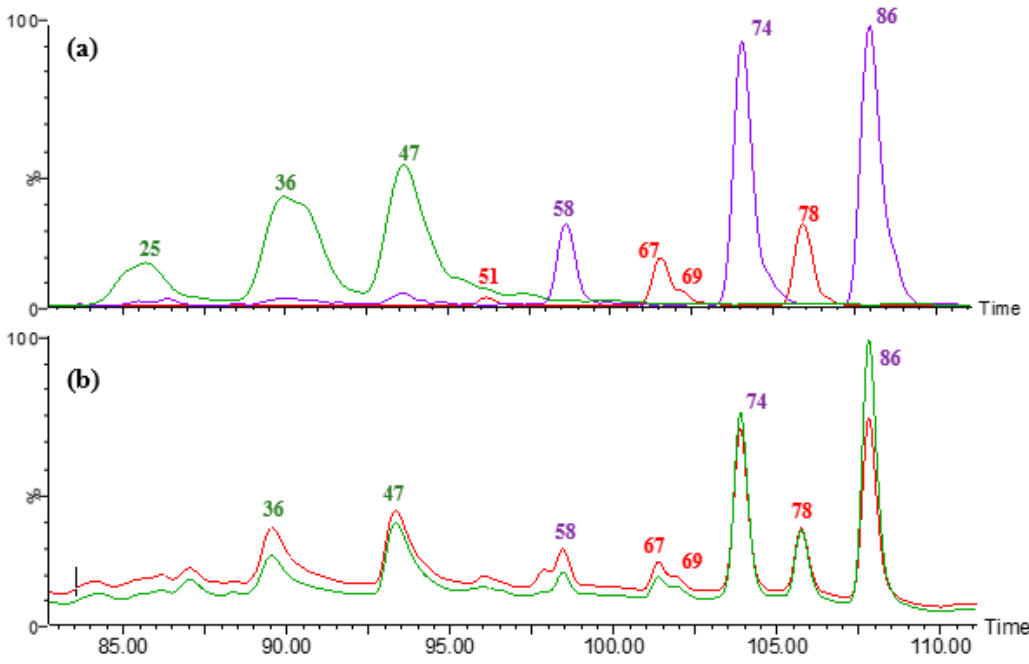
Figure 3. ( a ) Extracted-ion chromatogram (XIC) of hydroxycinnamic acid amides (HCAAs) of broa Verdeal de Aperrela SF, at m / z 411 (red), 438 (green), and 441 (purple). ( b ) Chromatogram of broa SF, at 280 nm (red) and 320 nm (green). Peaks are labelled as described in Table